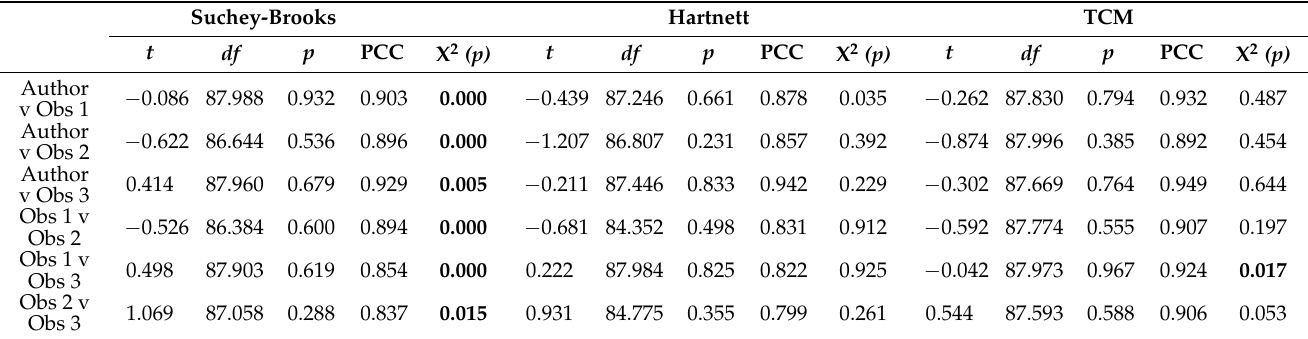
Table 11. Inter-observer comparisons by estimation method, observer subset (females, n = 50).